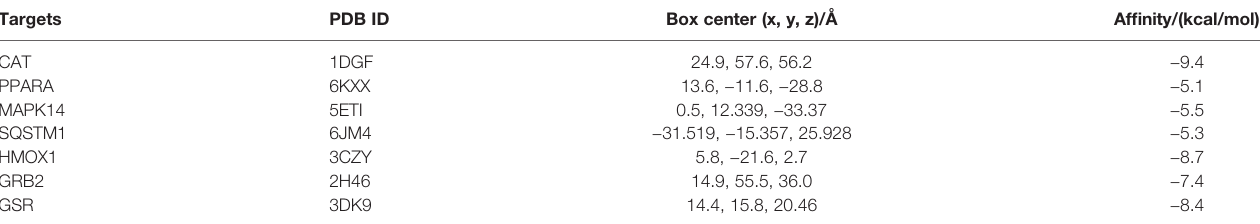
TABLE 2 | Molecular docking parameters and binding free energy.